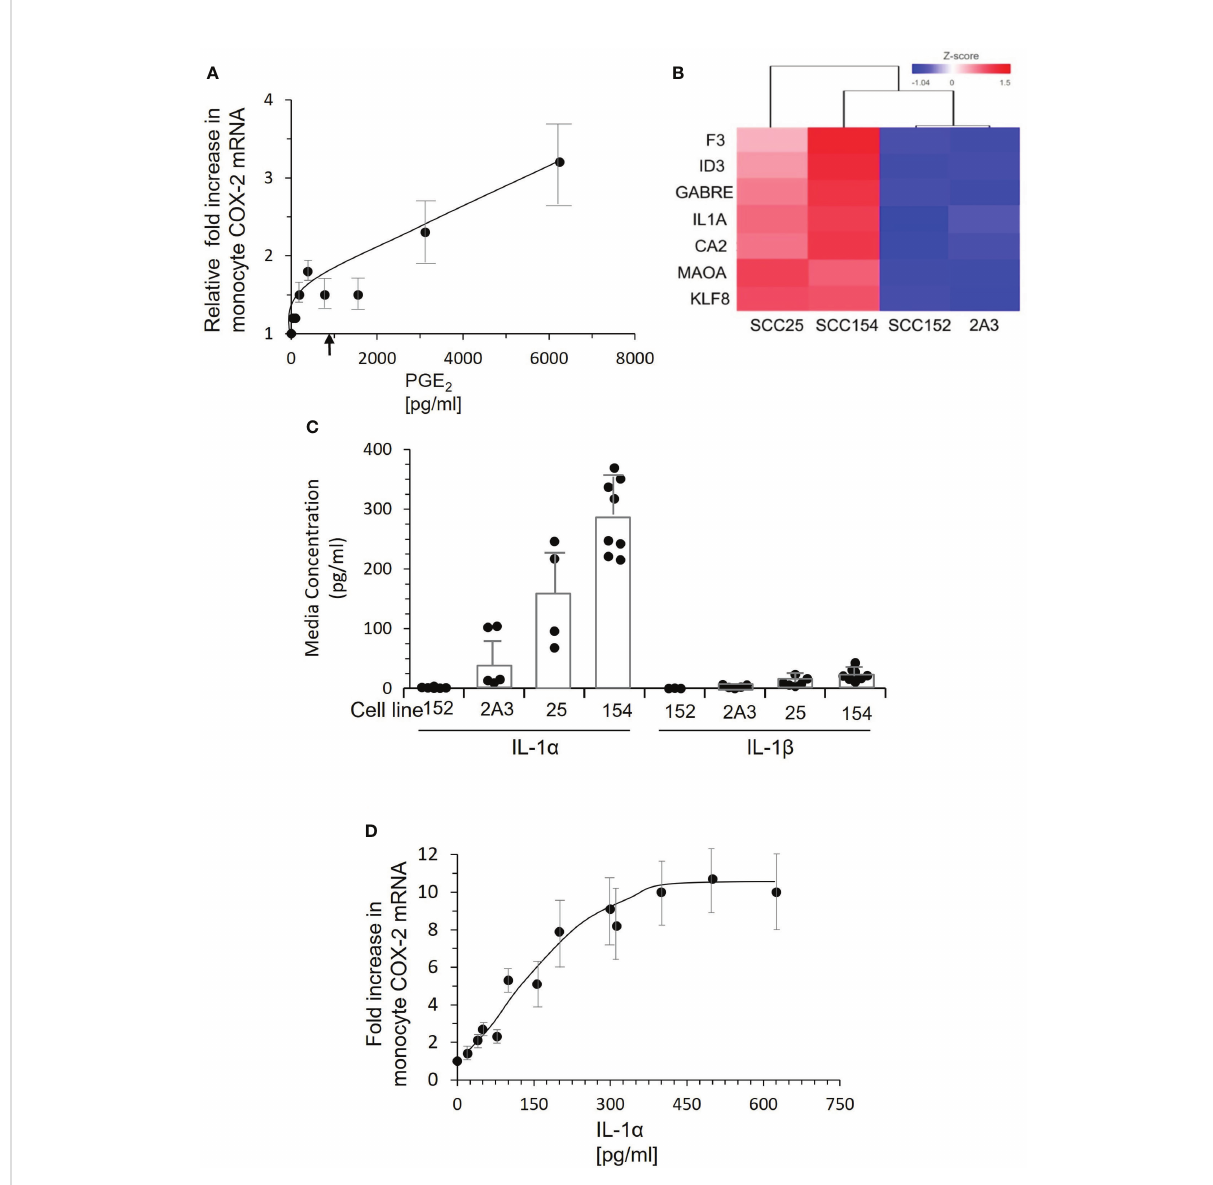
FIGURE 6 PGE 2 is not the inducing factor. IL-1 a present in conditioned medium of tumor lines SCC-25 and SCC-154 induces COX-2 expression in monocytes. (A) Control monocytes were stimulated with increasing concentrations of PGE 2 , and COX-2 mRNA measured by qPCR. Each dot represents the mean and SD of four measurements with different preparations of monocytes. There is a clear dose response, but the levels of COX-2 mRNA at doses below 2000 pg/mL are very low compared to the response of monocytes to conditioned media from tumor cells. The arrow indicates the mean level of PGE 2 in conditioned medium from cultures of three tumor biopsies. (B) RNA-seq analysis of two OPC/oral cancer cell lines that induced COX-2 compared to two cell lines that did not. The top genes selectively expressed by the inducing lines are shown. (C) Concentrations of IL-1 a and IL-1 b in conditioned medium from cell lines and primary OPC biopsy cultures were measured by ELISA. Dots represent different batches of media; bars are mean ± SD. (D) Control monocytes were stimulated with increasing concentrations of recombinant IL-1 a for 18 hrs., and COX-2 mRNA measured by q-RT PCR. Each dot is the mean ± SD of 3-4 measurements with separate isolates of monocytes. Approximately 50 pg/mL IL-1 a is required to elicit a two-fold increase in COX-2 mRNA, saturating at 300-400